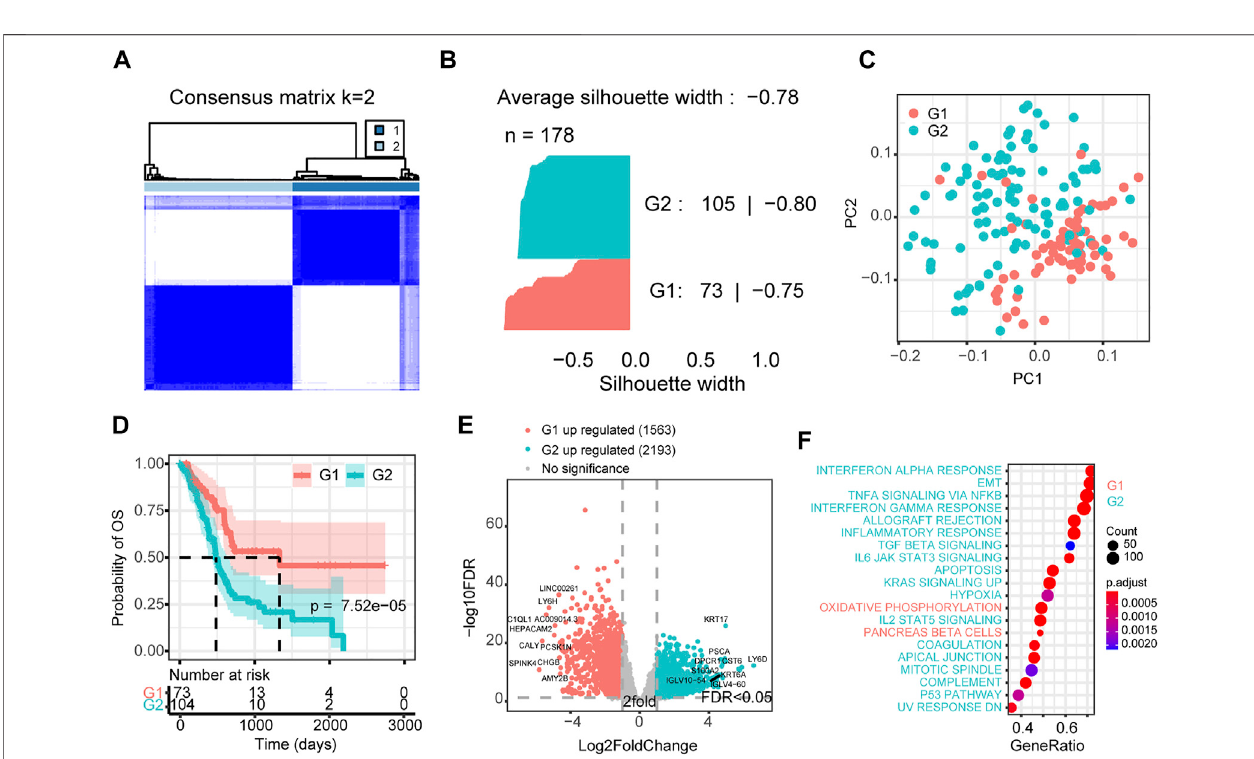
FIGURE4| ConsensusclusterofPAADsamplesbasedontop-rankedgenes. (A) ConsensusclusterheatmapofPAADsamples. (B) Thesilhouetteplotofthetwo clusters (G1/2) de fi ned by the top-ranked genes. (C) Principal component analysis of the total mRNA expression pro fi le in the TCGA dataset. (D) Kaplan – Meier OS curvesfordifferentsubgroups. (E) DifferentiallyexpressedgenesbetweenG1andG2subgroup. (F) GSEAanalysisofdifferentiallyexpressedgenesbetweenG1andG2 subgroup by using hallmark pathways. G2: high-risk subgroup; G1: low-risk subgroup.